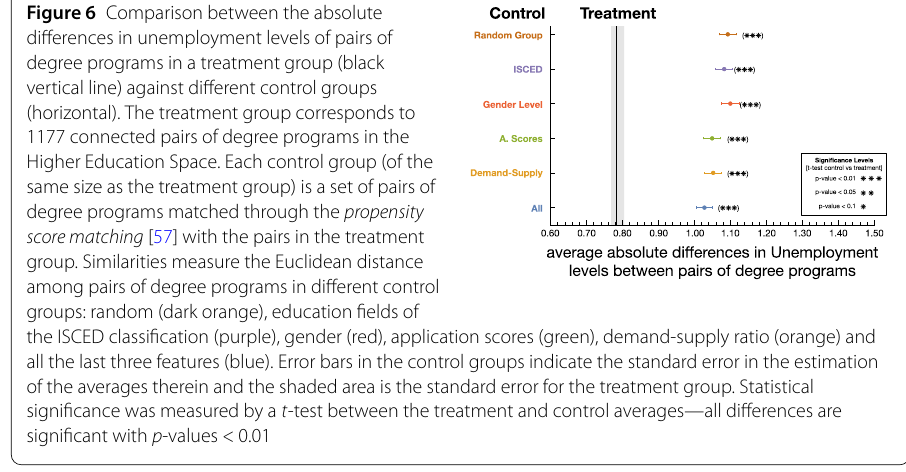
Figure 6 Comparison between the absolute differences in unemployment levels of pairs of degree programs in a treatment group (black vertical line) against different control groups (horizontal). The treatment group corresponds to 1177 connected pairs of degree programs in the Higher Education Space. Each control group (of the same size as the treatment group) is a set of pairs of degree programs matched through the propensity scorematching [57] with the pairs in the treatment group. Similarities measure the Euclidean distance among pairs of degree programs in different control groups: random (dark orange), education fields of the ISCED classification (purple), gender (red), application scores (green), demand-supply ratio (orange) and all the last three features (blue). Error bars in the control groups indicate the standard error in the estimation of the averages therein and the shaded area is the standard error for the treatment group. Statistical significance was measured by a t -test between the treatment and control averages—all differences are significant with p -values <